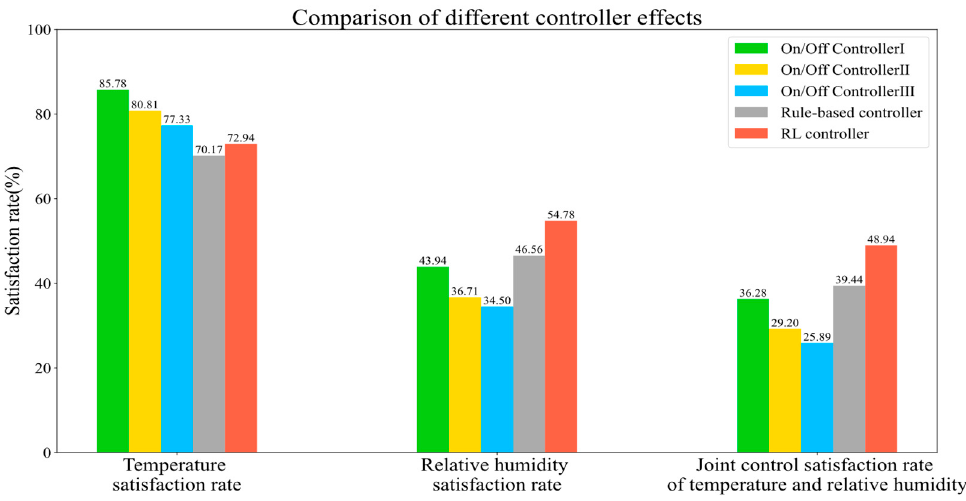
Figure 12. Comparison of different controller effects.